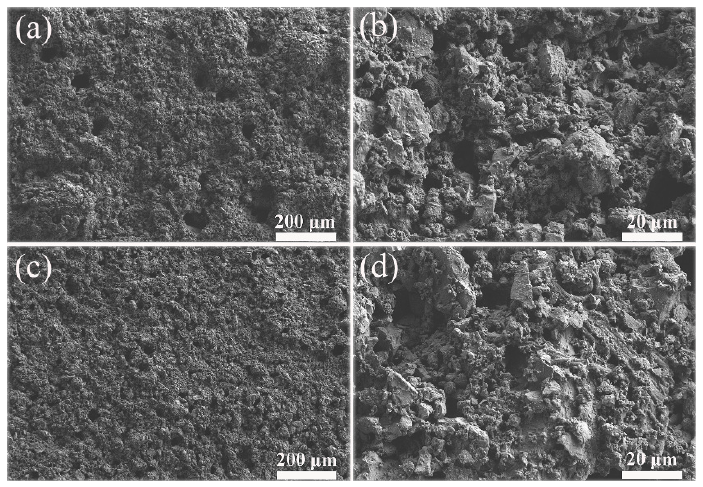
Figure 7. FE-SEM images of two kinds of PC coatings: ( a ) and ( b ) PC coatings without using hydrophobic emulsion; ( c ) and ( d ) PC coating containing hydrophobic emulsion.